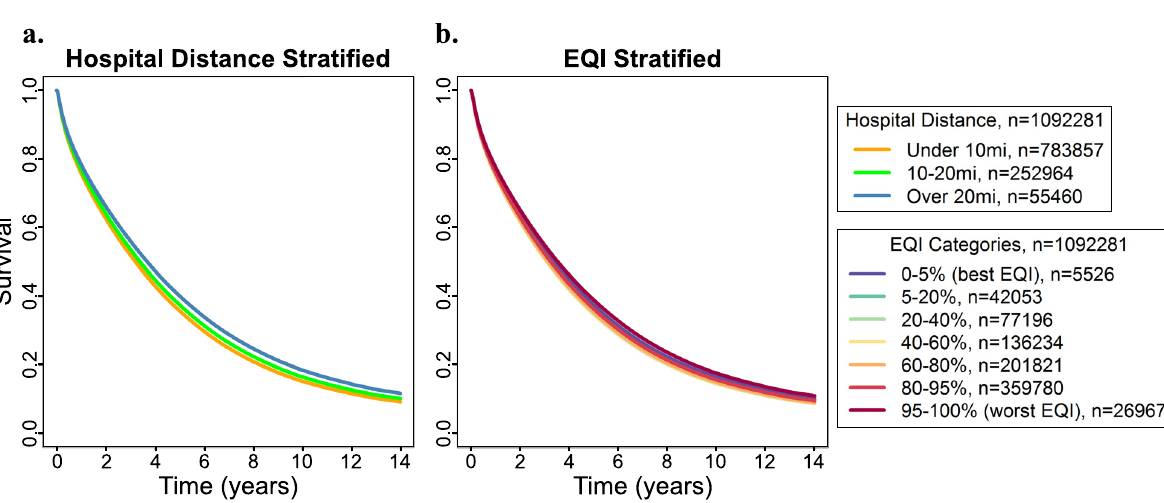
Fig 1. Adjusted survival curves for all patients developed using the full model mutually adjusted for average distance to the nearest hospital and total EQI. (a) Quantiles were generated using distance from the nearest hospital, (b) Quantiles were generated using total EQI.